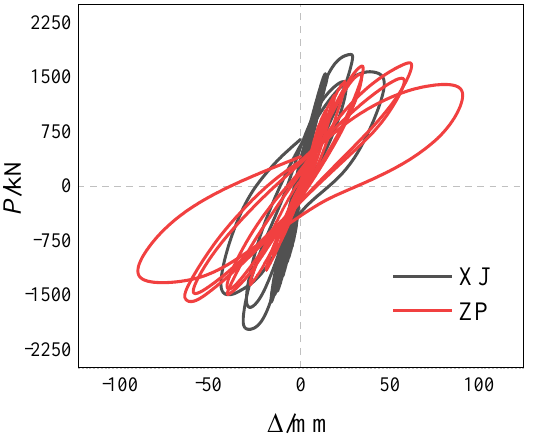
Figure 9. Load – displacement hysteresis curves of specimens XJ and ZP.